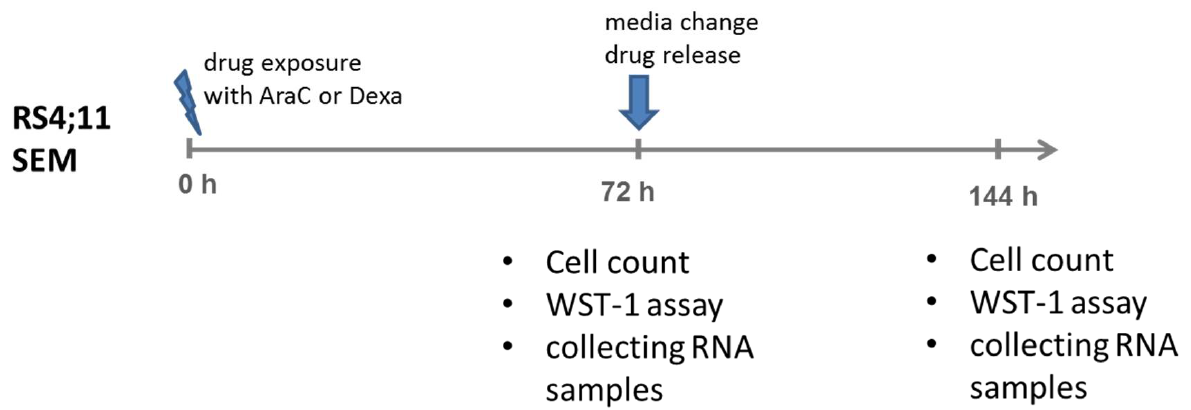
Figure 1. Schematic diagram for the experimental setup to study relapse mechanisms and identify biomarkers for relapse in pro-B-ALL. Two settings were chosen: (1) drug exposure for 72 h, followed by (2) no drug exposure (“drug release”) for an additional 72 h, noted here as 144 h (+/ − ). In the experimental readout, trypan-blue staining (cell count), WST-1 assay (cell count and metabolism analysis) and sample collection for following RNA-Seq of RS4;11 and SEM were